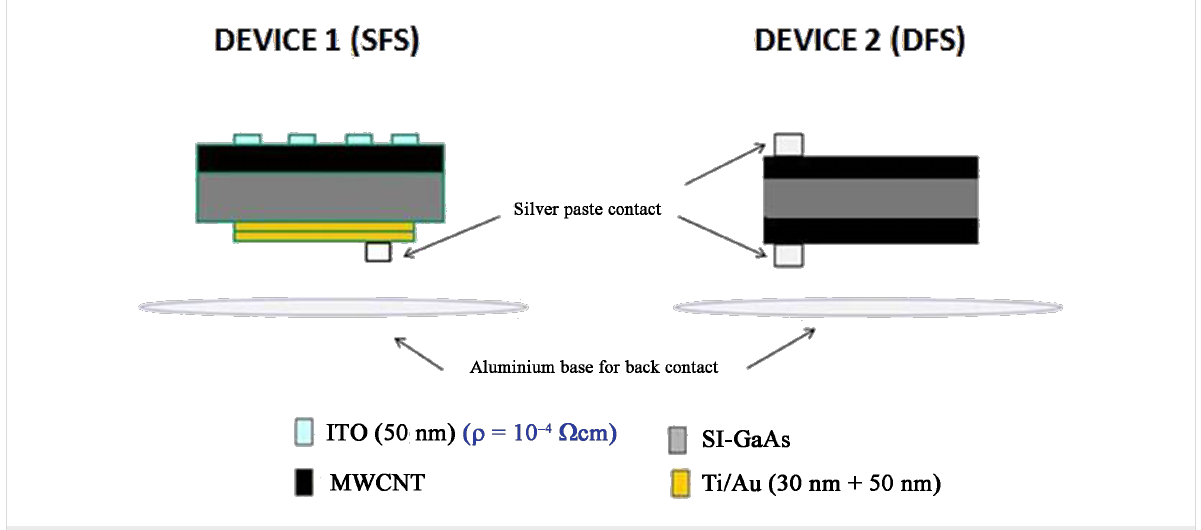
Figure 1: Schematic image of the two device layouts used: single face sample (SFS) and double face sample